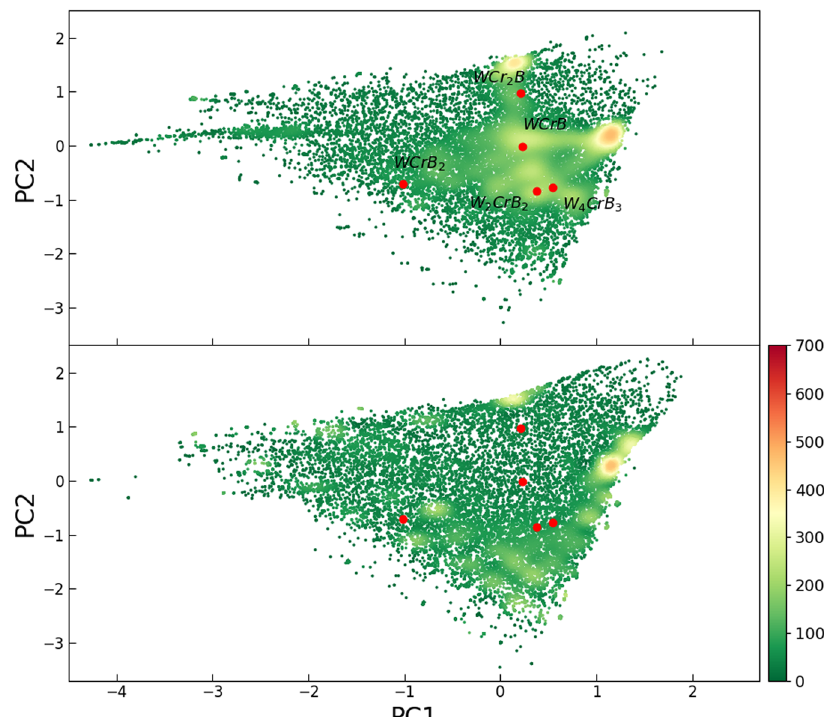
Fig. 8 PCA maps of the W – Cr – B system. Structures are taken from the COPEX (upper panel) and USPEX (lower panel), respectively. The map is colored according to the sampling intensity, divided into 29 × 26 bins, and the color bar refers to the number of sampled structures in each bin. The fi ve stable ternary compounds are highlighted by red dots. The PC1 and PC2 refer to the fi rst and second principal components,